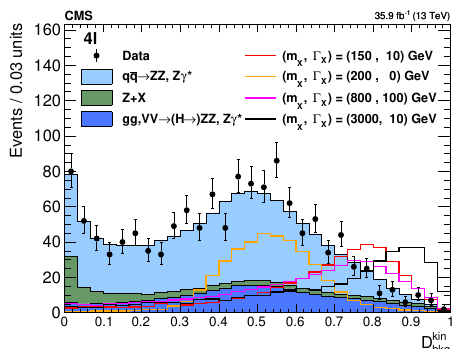
Figure 3 . Distributions of D kin for all selected events. Signal expectations including the interfer- bkg ence e(cid:11)ect for several mass and width hypotheses are shown. The signals are normalized to a total of 400